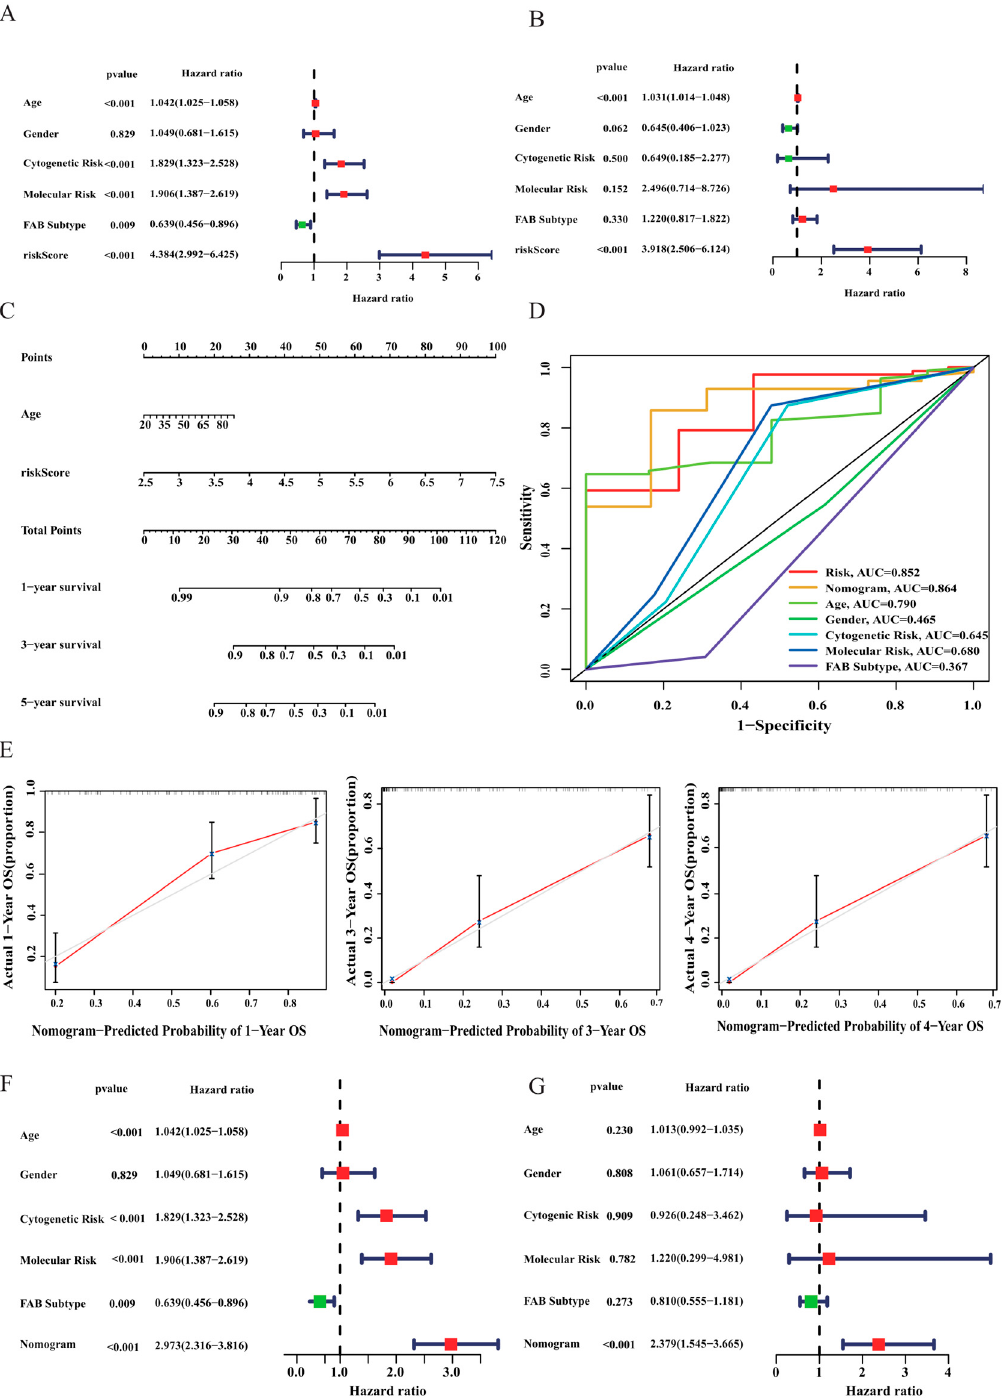
Figure 6. Development and assessment of the nomogram for patients with AML. ( A , B ) Univariate and multivariate Cox regression analyses of clinical parameters in patients with AML. ( C ) Nomogram to predict the 1-, 3-, and 4-year OS of AML patients. ( D ) ROC curves of the nomogram, risk score, and clinical characteristics in predicting prognosis. ( E ) Calibration plot analysis to evaluate the predictive ability of the nomogram. The x -axis is nomogram-predicted survival, and the y -axis is actual survival. ( F , G ) Univariate and multivariate Cox regression analyses were conducted to identify if the nomogram score was an independent predictor in AML patients. Green squares: Hazard ratio (HR) < 1; red squares: HR > 1.